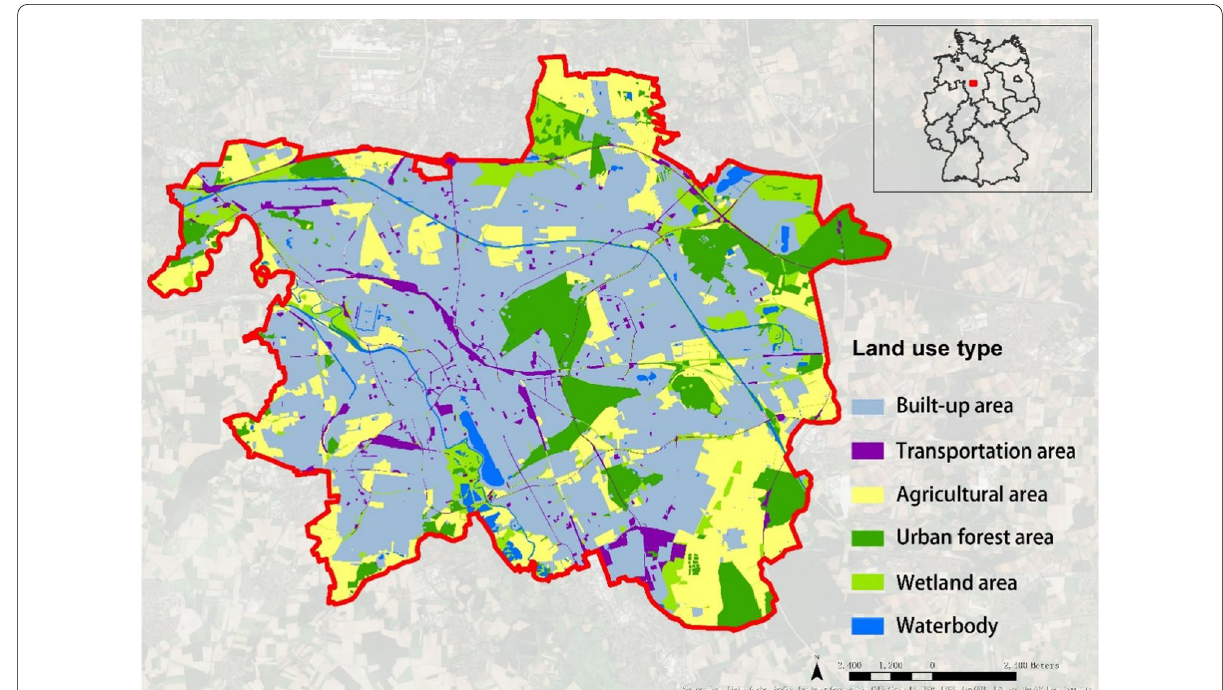
Fig. 3 Land use classification in the city of Hannover. There are several large urban forests in the city and a few wetlands scattered near the city boundary (source: DLM Region Hannover)